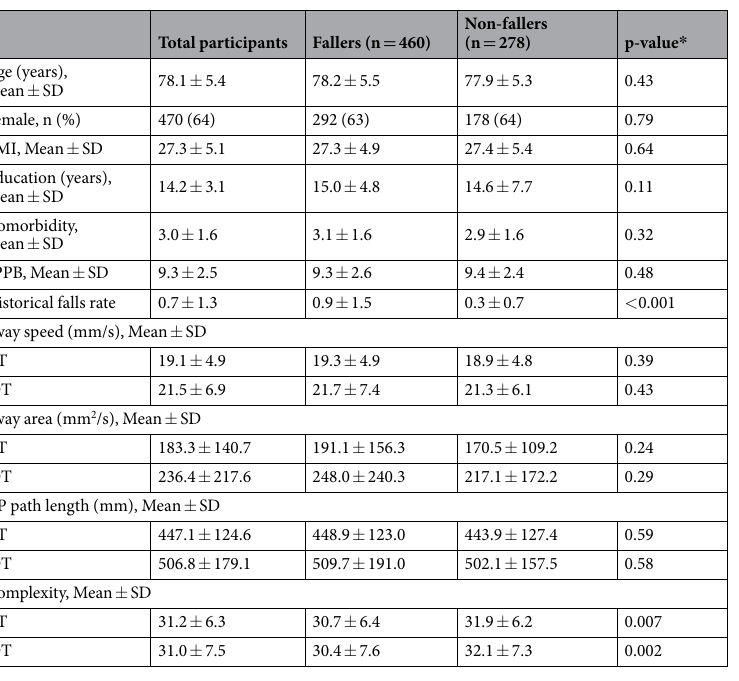
Table 1. Demographics of fallers and non-fallers. * ANOVAs and Chi-Square test (for sex) were used to determine the differences in these characteristics between fallers and non-fallers. Note: BMI = body mass index; ST = single task standing; DT = dual task standing; AP =